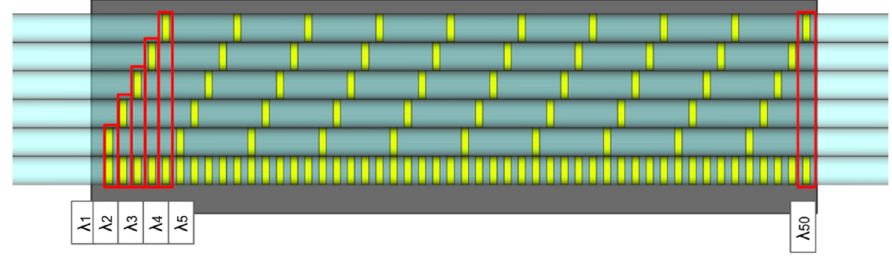
Figure 1. Arrangement of FBGs in highly dense and sparse temperature sensors.